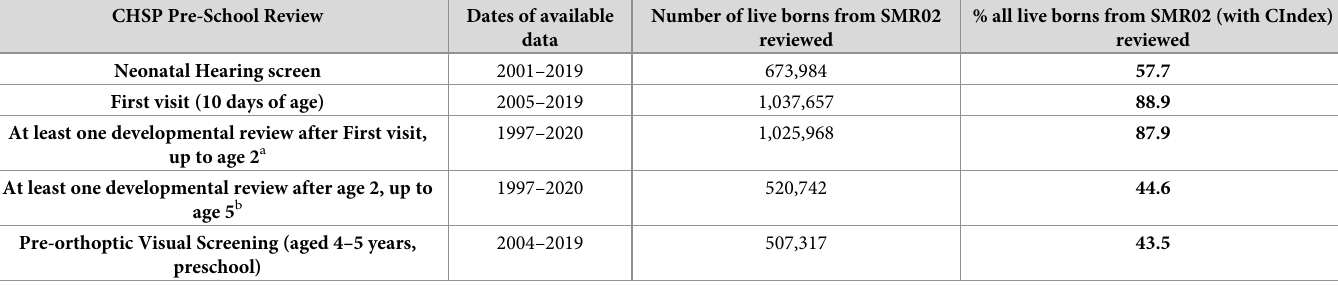
Table 5. Rates of Child Health Systems Programme Pre-School reviews for live births from SMR02 (with Child Indexes). CHSP Pre-School Review Dates of available